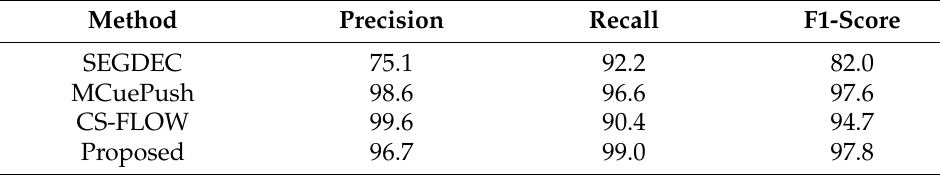
Table 4. Performance of defect detection method on magnetic tile dataset.